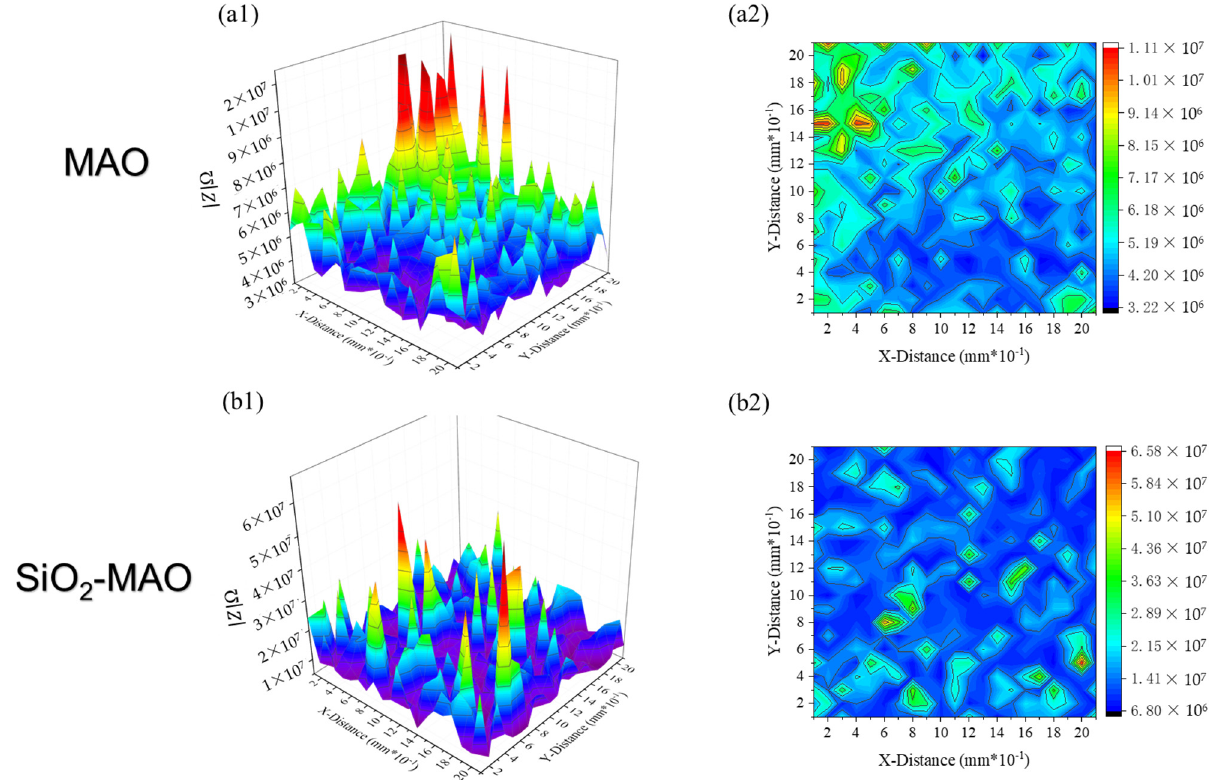
Figure 10. Local impedance of the non-scratched coating, ( a1 , a2 ) MAO coating, ( b1 , b2 ) SiO 2 /MAO coating.